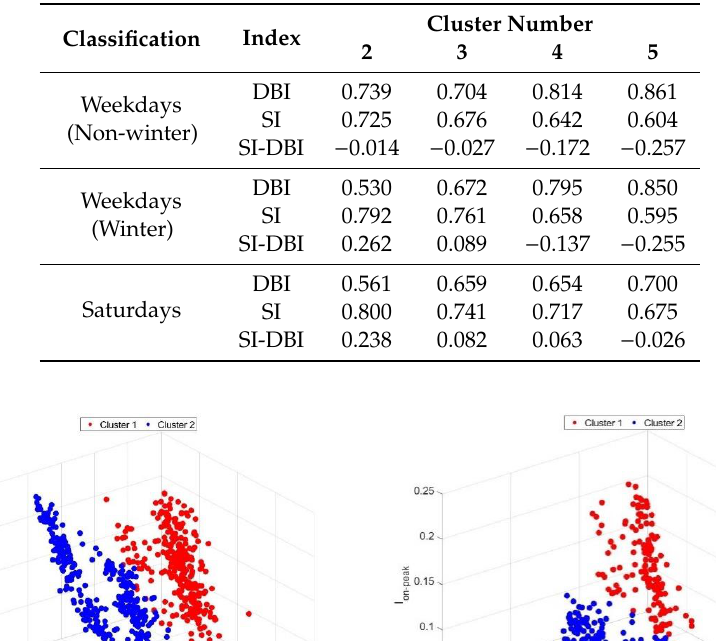
Table 4. Internal evaluation indices at di ff erent cluster numbers based on K-means.